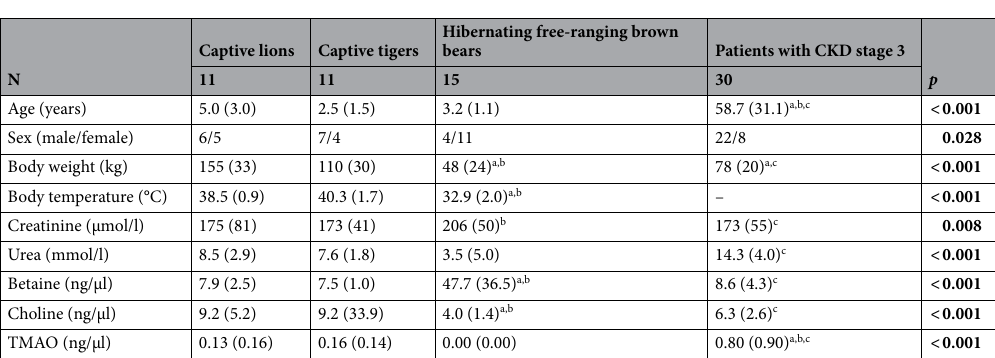
Table 2. Betaine, choline, TMAO and renal markers in CKD-susceptible felids and CKD-protected hibernating bears in comparison to CKD stage 3 patients. Betaine, choline, TMAO, and renal markers in different animal species with a chronic kidney disease (CKD)-like status, e.g. in captive lions, captive tigers, and hibernating, free-ranging brown bears, as well as in patients with CKD stage 3. CKD, Chronic kidney disease; all other abbreviations as indicated in Table 1. Values for median (interquartile range) or total number are shown. Continuous parameters were analysed by Kruskal–Wallis test followed by post-hoc analysis, whereas Chi-squared-test was used for all categorical variables. p values for overall group differences are depicted. Letters in superscript indicate p < 0.05 as compared to captive lions a , captive tigers b , or hibernating, free-ranging brown bears c in post-hoc